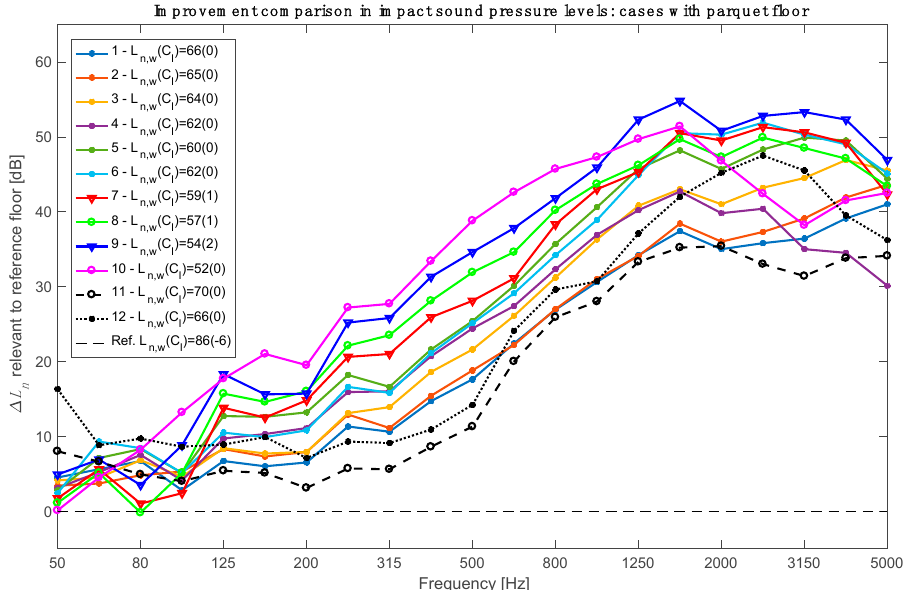
Figure 4. Improvements provided in terms of normalized impact sound pressure levels ∆ L n of the test floors relative to the reference CLT floor. Floors 3–6 (with double vibration mat) show increasing impact sound insulation. In contrast to the airborne sound analysis, floor 5 (two gypsum layers and two plywood lay- ers on top of double vibration isolation) performs slightly better than floor 6 in middle